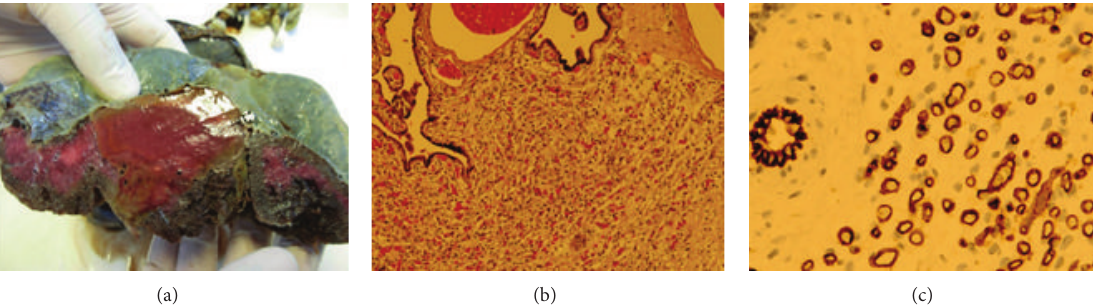
Figure 2: (a) At the cutting the area was of solid appearance with triangular base on the fetal side, near to the cord insertion, with a maximum size of 7 cm. (b) By microscopic examination the lesion was composed of proliferation of capillary structures of small caliber, single coated with endothelial cells (100x). (c) The CD31, a specific marker of endothelial cells, puts greater emphasis on the typical structure of a placental chorioangioma